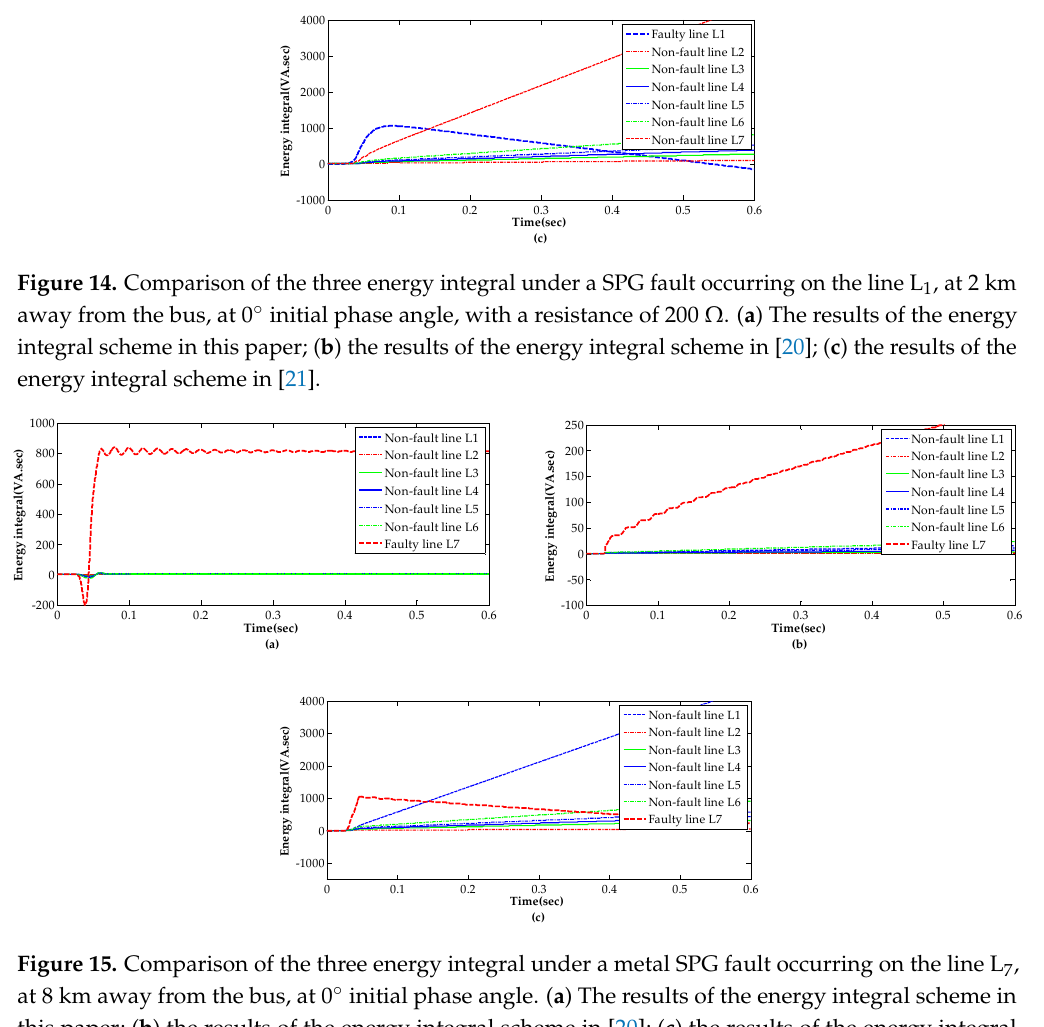
Figure 15. Comparison of the three energy integral under a metal SPG fault occurring on the line L 7 , at 8 km away from the bus, at 0 ◦ initial phase angle. ( a ) The results of the energy integral scheme in this paper; ( b ) the results of the energy integral scheme in [20]; ( c ) the results of the energy integral scheme in [21].